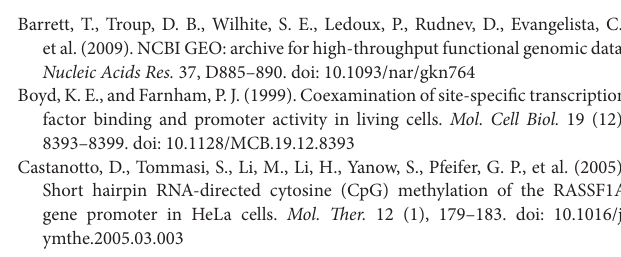
TABLE S1 | Oligonucleotide sequences used in pyrosequencing. TABLE S2 | Oligonucleotide sequences and conditions for PCR and qPCR analyses. TABLE S3 | Contingency tables, odds ratios (ORs), 95% confidence intervals, and p- values. FIGURE S1 | Distribution of DNA bases on methylation and AGO4-binding sites. FIGURE S2 | Distribution of AGO4-binding sites on gene promoters. FIGURE S3 | Proving of AGO4-binding genes. FIGURE S4 | Confirmation of AGO4 protein associated to methylation level in AGO4-binding genes, independently function to DNA methyltransferase (DNMT). FIGURE S5 | Recovery of methylation level in some gene-containing AGO4- binding sites, in concordance with the presence of the AGO4 proteins after withdrawal of 5’-azacytidine. FIGURE S6 | Tetracycline (Tet) (the first panel), and 5’-azacytidine and combined tetracycline and 5’-azacytidine treatment (the second panel) in scramble shRNA- transfected HEK293 cells. FIGURE S7 | AGO4 protein expression in AGO4 plasmid and scramble shRNA- transfected and -untransfected HEK293 cells at 48 h after